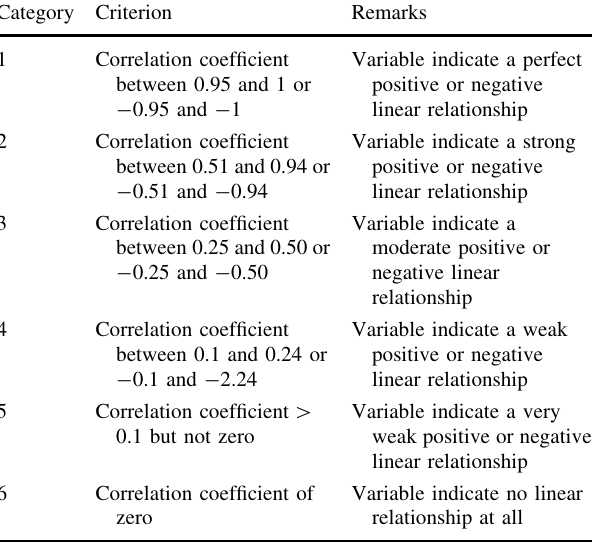
Table 1 Criterion set for factors affecting spontaneous combustion liability of coals and